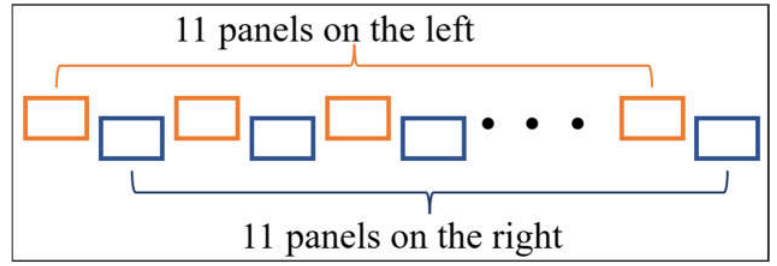
Figure 1. Layout of the experimental floor panels.